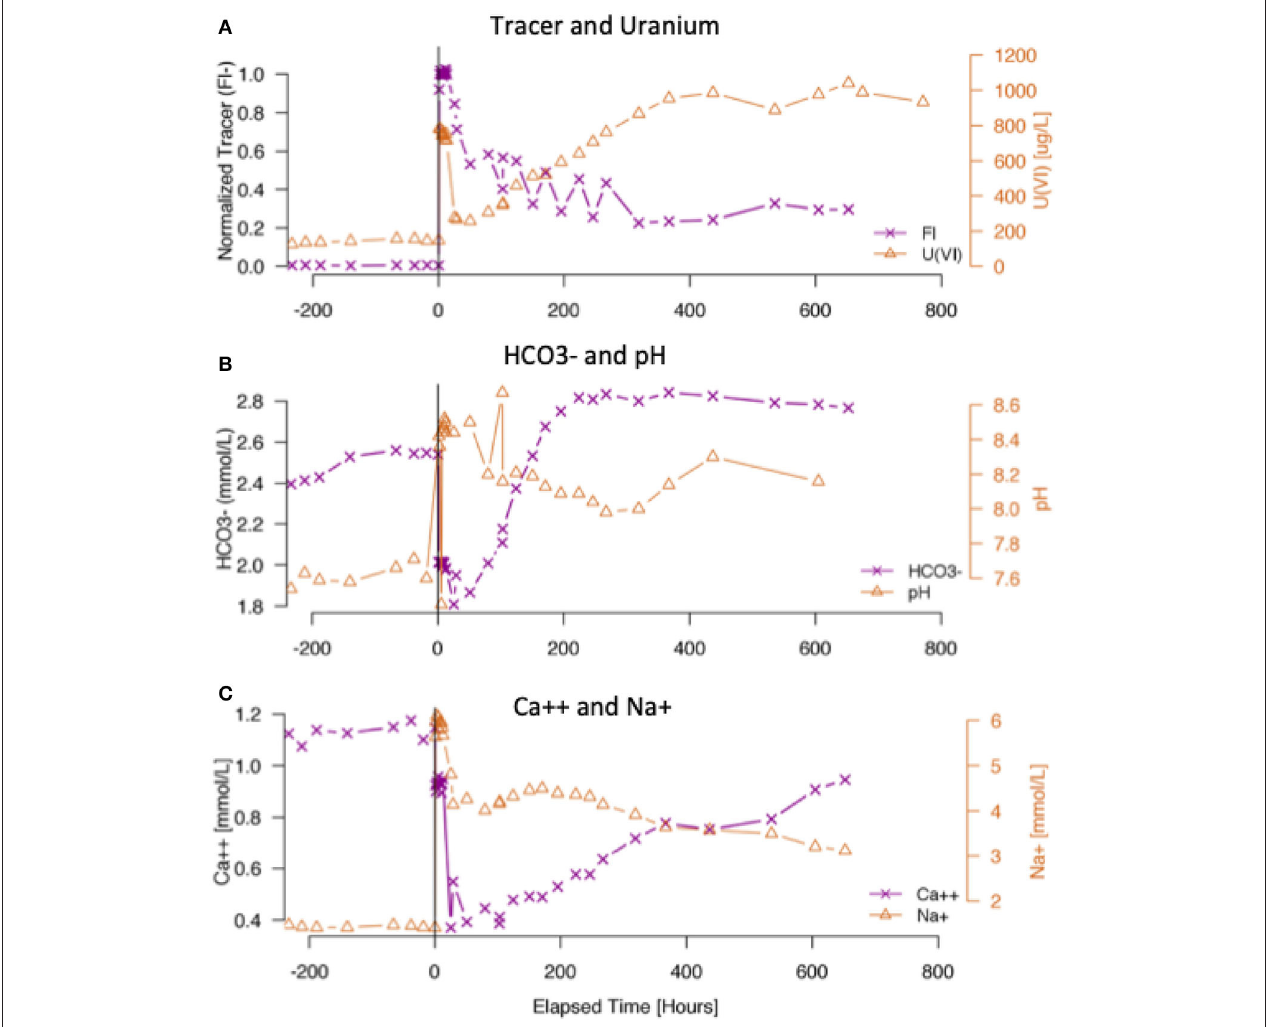
FIGURE 4 | Concentrations of tracer and uranium (A) , HCO3 − and pH (B) , and Ca ++ and Na + (C) at the injection well 2–28 during the intermediate zone injection test. Time zero refers to the start of the injection.